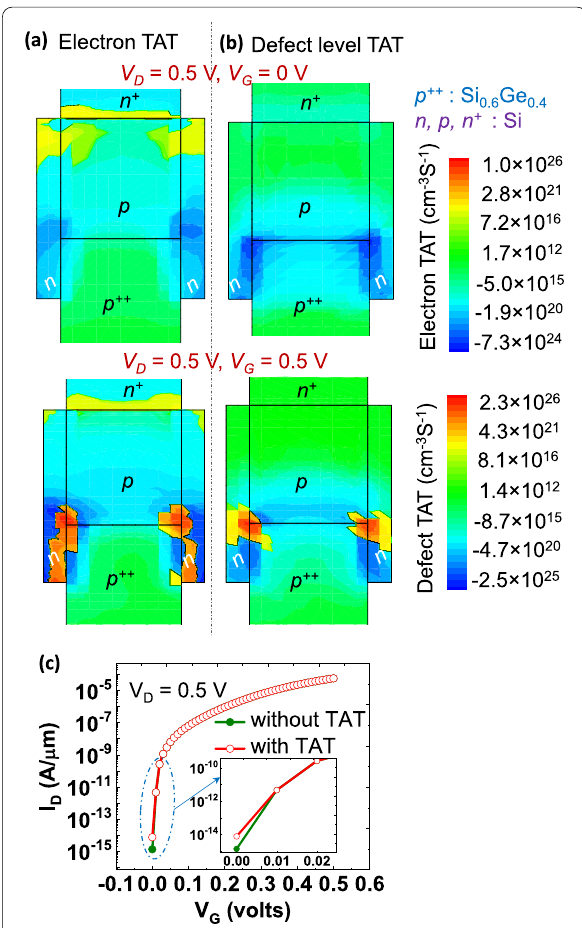
Fig. 7 The TAT of FATFETs in both the off-state ( V D = 0.5V , V G = 0V ) and on-state ( V D = 0.5V , V G = 0.5V ) states, resulting from a position-dependent electron TAT and b defect level TAT, respectively. Position dependent electron TAT can be identified along the p ++ - n and p - n junctions, while defect level TAT at the Si/ Si 0.6 Ge 0.4 interfaces. c Impact of TAT on I D – V G characteristics; inset shows less than 1-order high I off due to overall contribution of TAT